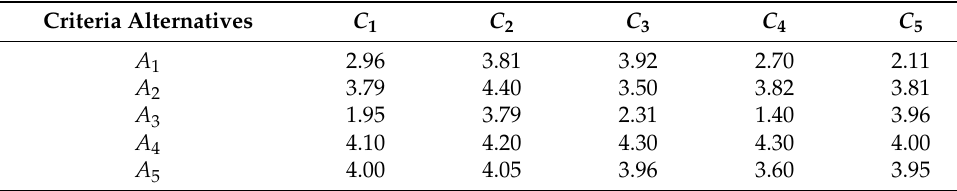
Table 8. The median of ratings obtained from the